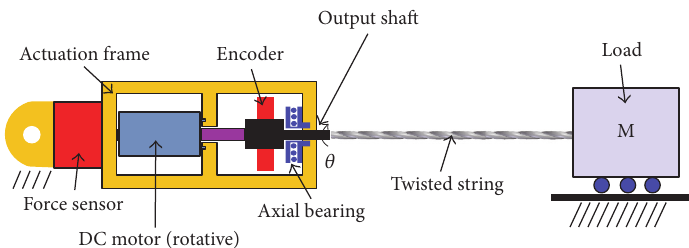
Figure 2: Schematic representation of the TSA structure.